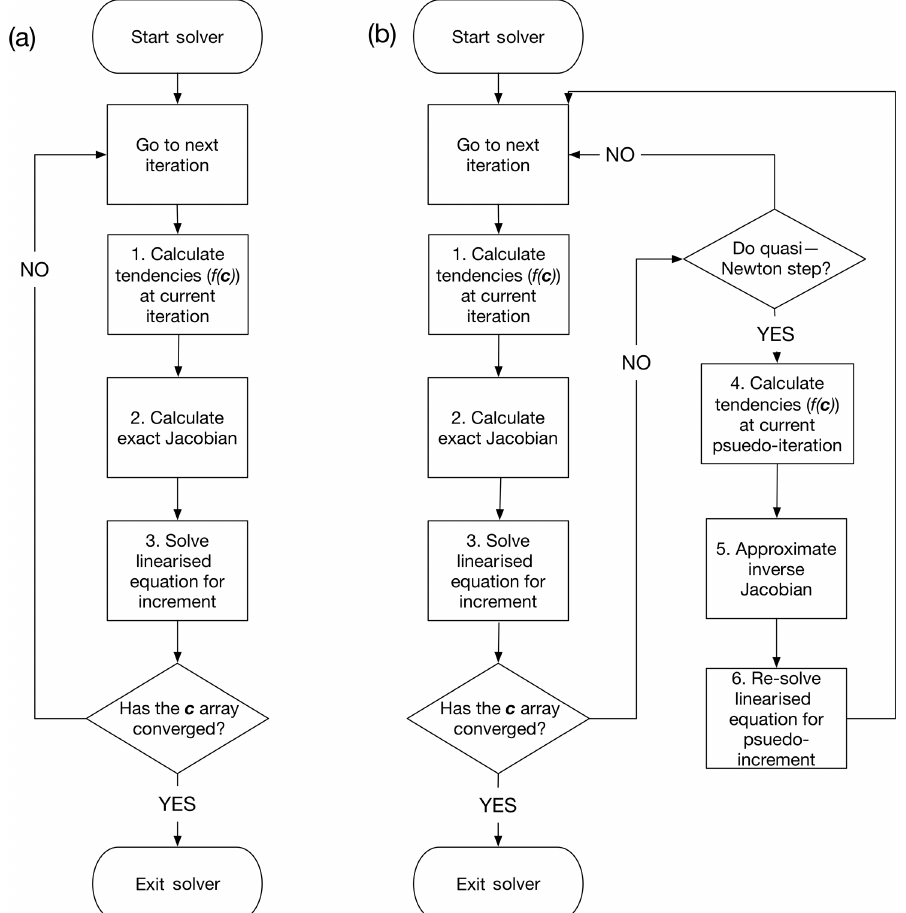
Figure 2. Flowchart showing steps taken to numerically solve the nonlinear chemical equations using the Newton–Raphson method: as carried out in the standard version of ASAD in the UKCA chemical transport model (a) and in our modified version incorporating a “quasi- Newton iteration” (b)